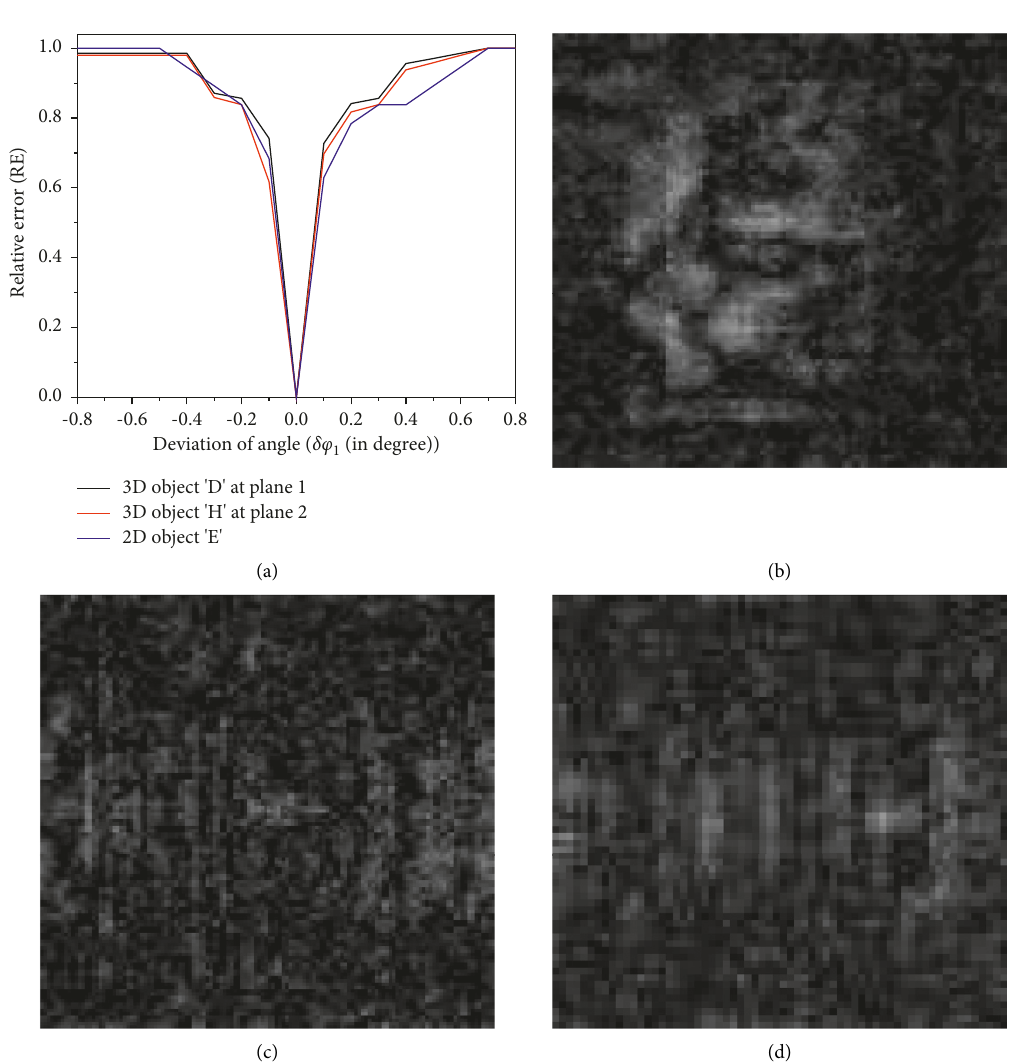
Figure 14: Decrypted results with wrong angle of p 2D object with wrong angle φ